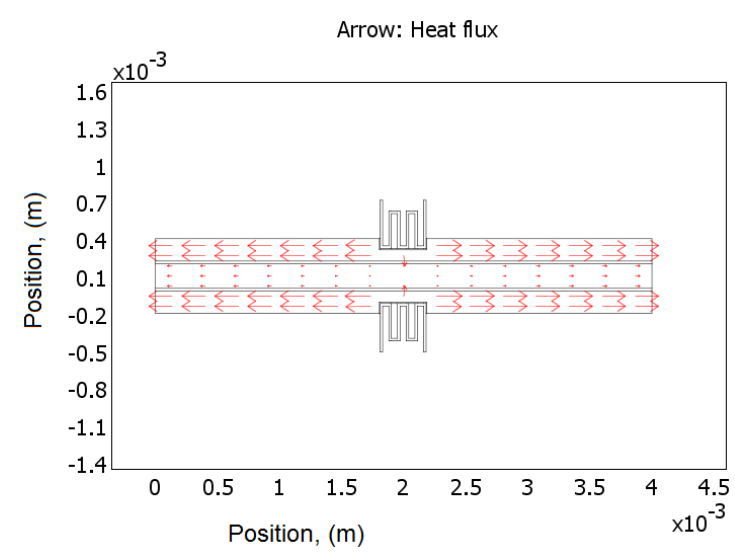
Figure 2. Simulation result of heat flux through CPW.